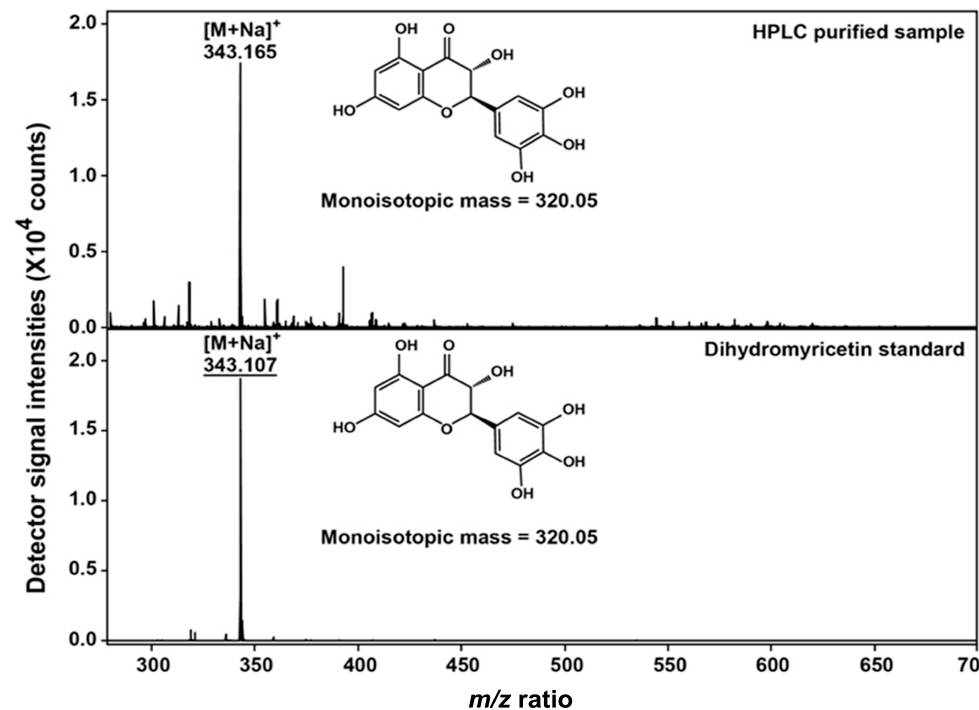
Figure 3. The obtained spectra of a HPLC-purified DHM sample (top) using matrix assisted laser desorption ionization-time of flight mass spectrometry (MALDI-TOF MS) in comparison to a DHM commercial standard spectra (bottom). Both the standard and sample were lyophilized and re-suspended in 10 µL H 2 O before mixing with 2,5-dihydroxybenzoic acid (DHB) solution [containing 4 mg/mL DHB in 30% acetonitrile, 0.1% TFA, and 1 mM sodium chloride] in 1:1 ratio before subsequent analysis.